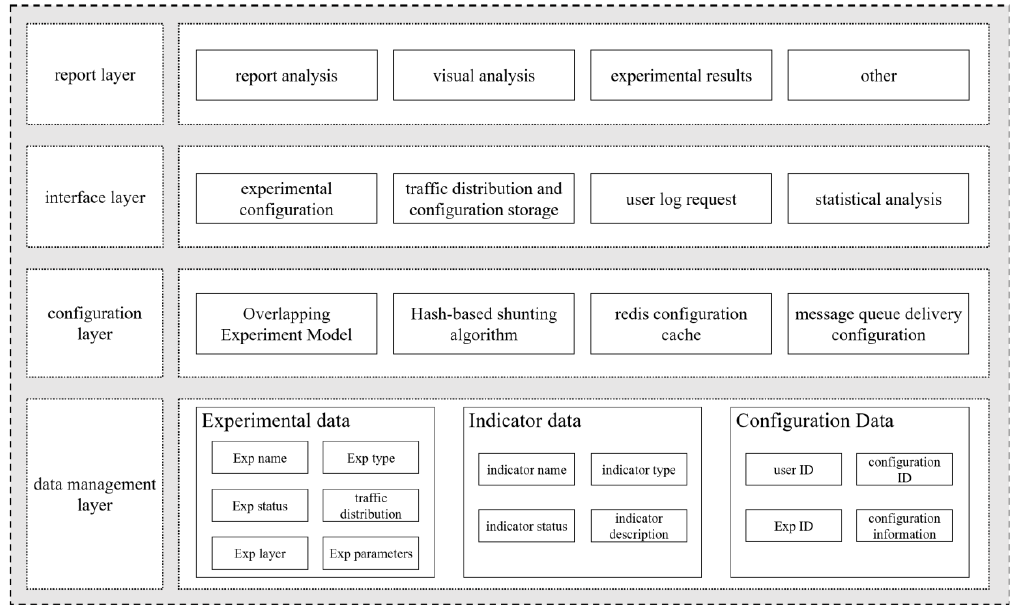
Figure 6. A/B testing system structure.